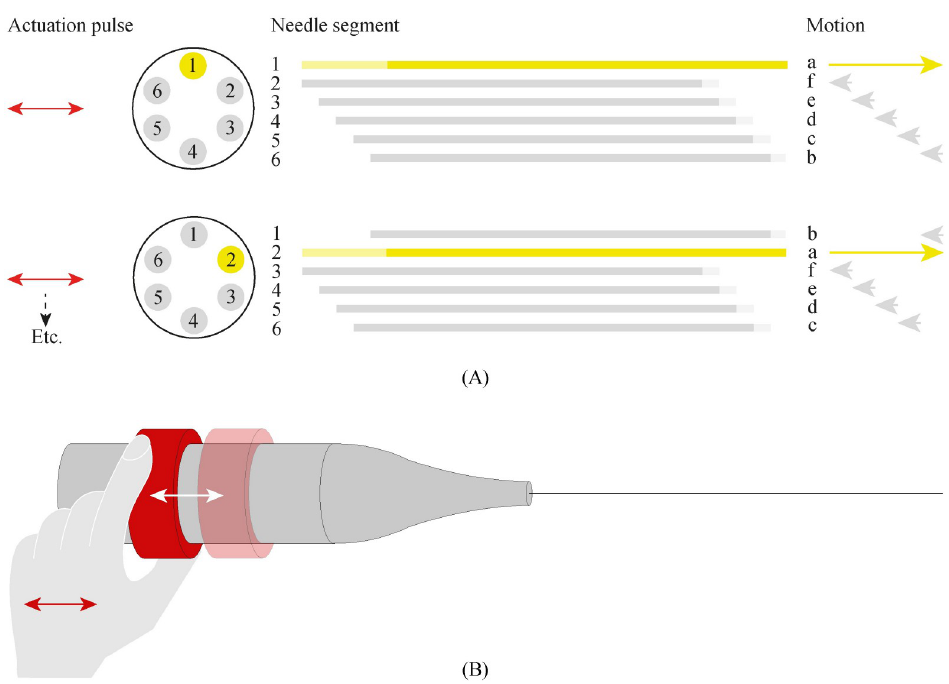
Fig 2. Visualisation of the motion sequence of the needle segments. (A) During the motion, one needle segment moves forward over the stroke distance while the other needle segments move slowly backwards over one-fifth of the stroke distance in a consecutive manner. (B) Manual translation of a translation ring (red) drives the actuation system. The actuation system converts the reciprocating motion of the translation ring into a sequential translation of the six needle segments.